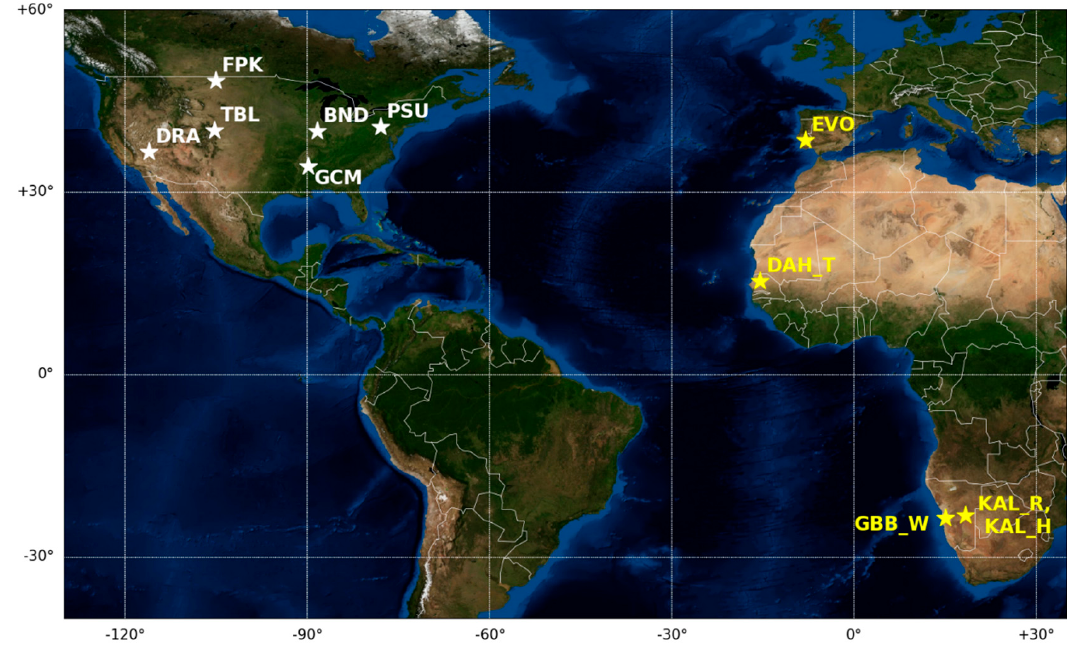
Figure 1. Locations of the in situ stations used for LST validation. The white stars indicate Surface Radiation Budget Network (SURFRAD) stations, the yellow stars Karlsruhe Institute of Technology (KIT) stations. Table 2. Details on the in situ stations used for LST validation.